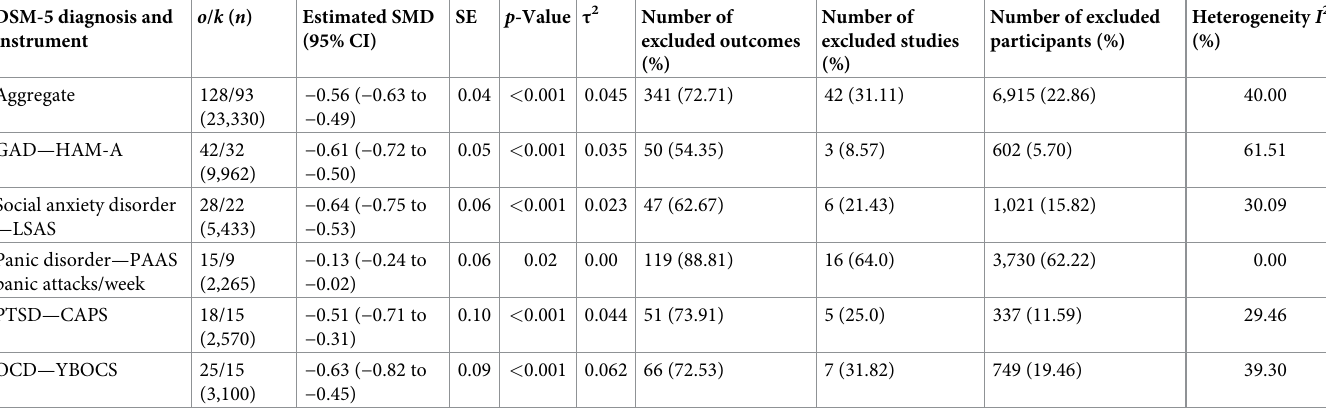
Table 4 AU : IeditedthefirstcolumnofTable 4 togiveboththediagnosisandtheinstrument : Pleasecheckforcorrectness : . SMD between medication and placebo for the most used assessment instrument according to standardized diagnosis of participants. DSM-5 diagnosis and instrument